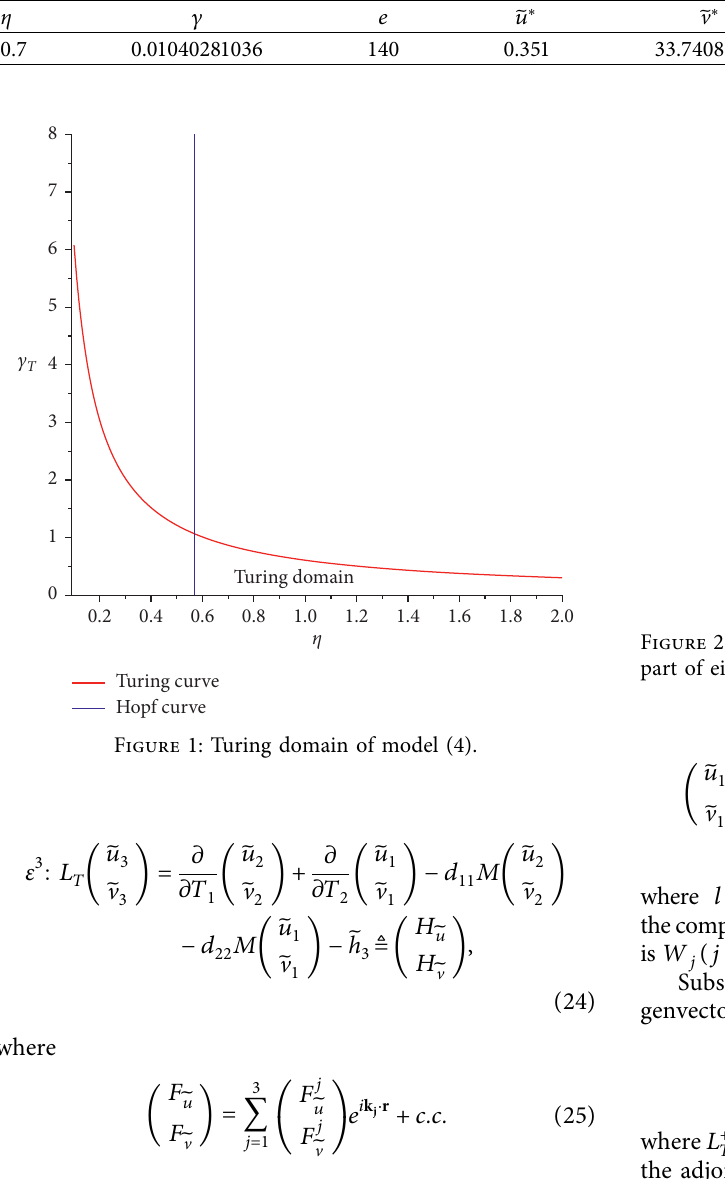
Table 2: An example to illustrate the existence and stability of the equilibrium of model (4).